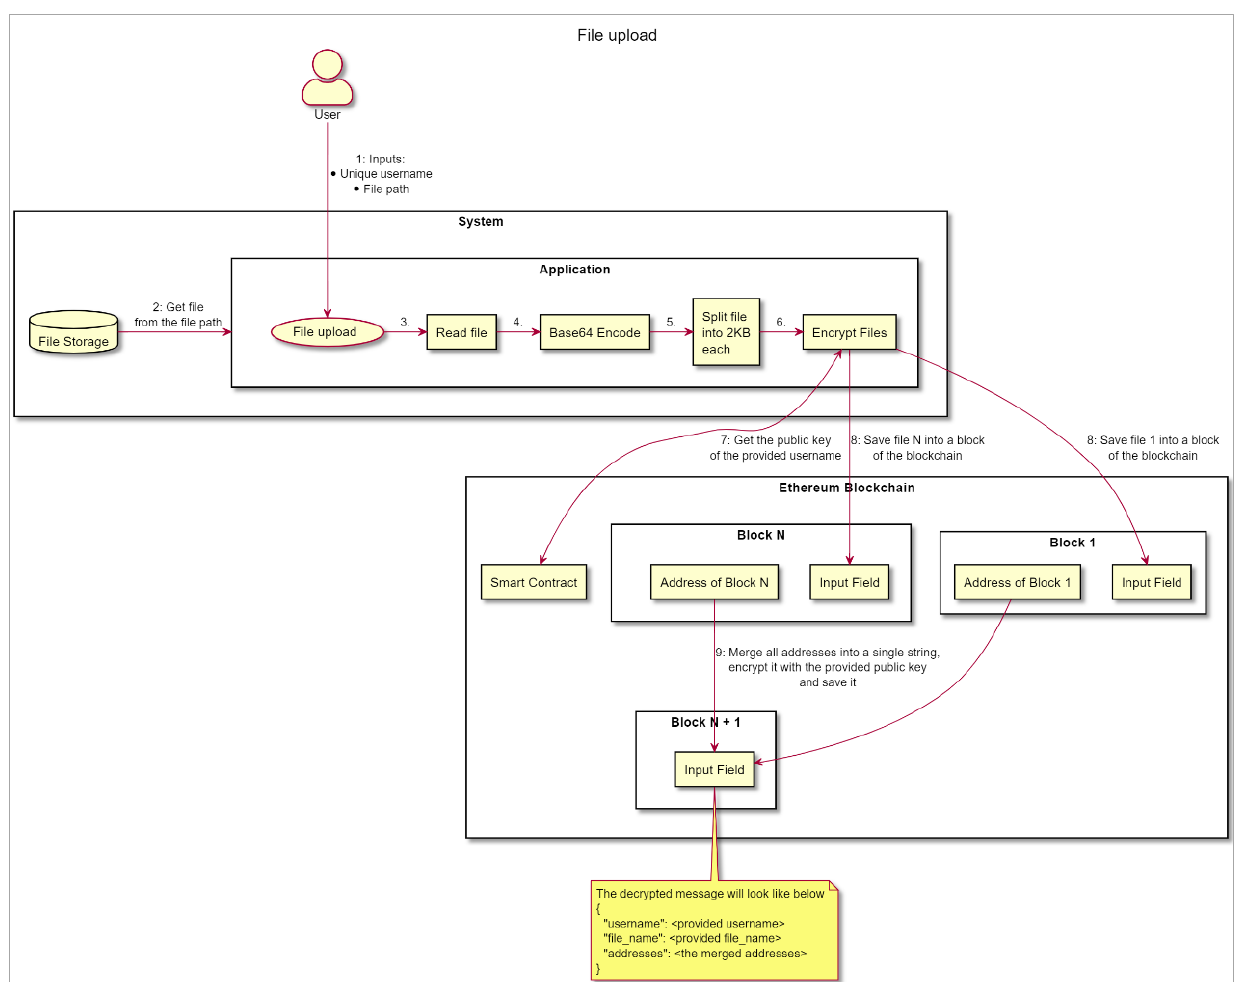
Figure 5. Flowchart of “Uploading a